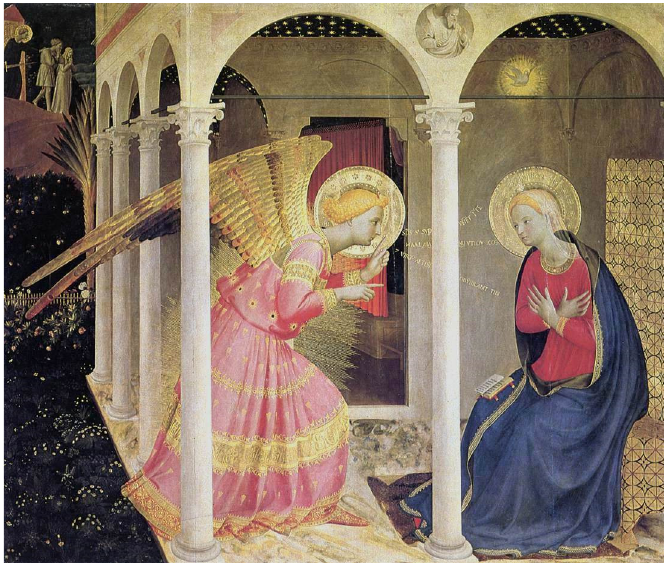
Figure 1. Fra Angelico, The Annunciation , c. 1433. Museo Diocesano di Cortona.